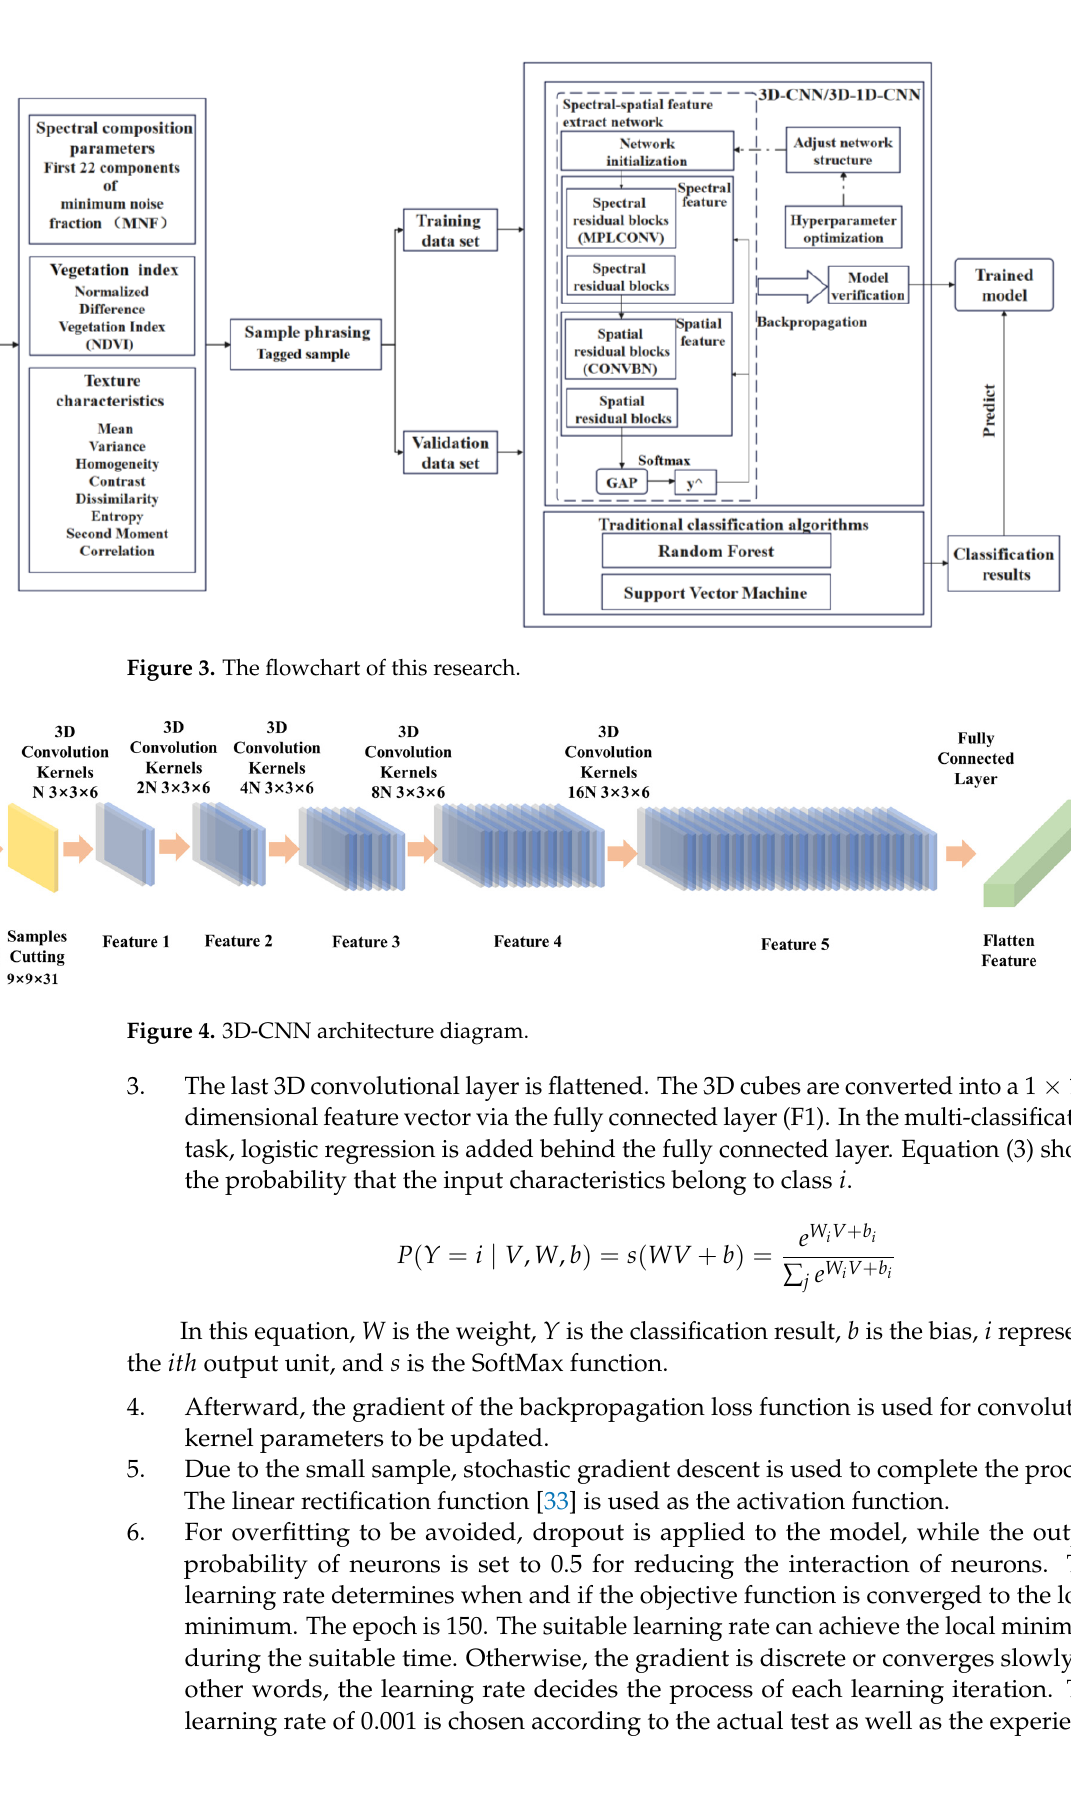
Figure 3. The flowchart of this research.